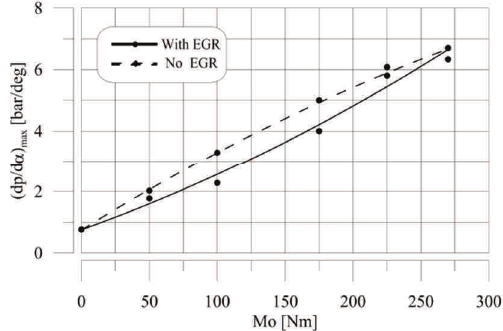
Fig. 7. Influence of the engine load on max rate of combustion pressure (dp/d a ) max for engine operating with/without